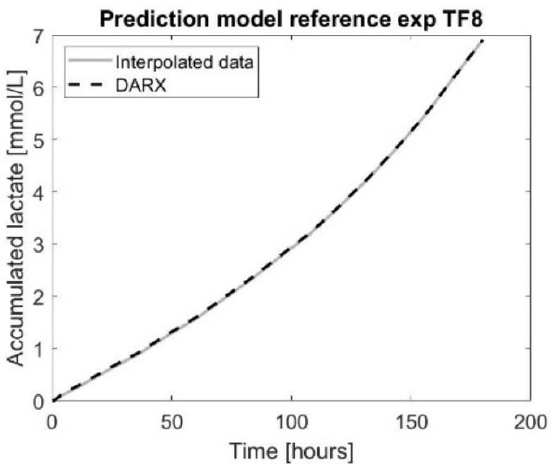
Figure 5. The prediction model using a dynamic auto-regressive exogenous (DARX) [1 1 1] model for accumulated lactate (mM) compared to the interpolated data for the experimental data of tissue flask eight of the reference experiment.